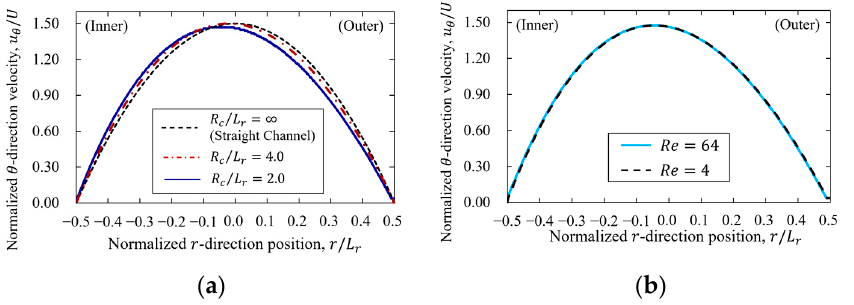
Figure 3. Velocity profiles of curvilinear channel with l = 200 cells. ( a ) Difference in velocity profiles between curvilinear channel and straight channel with Re = 32. ( b ) Reynolds number Re dependence using R c / L r = 2.0. Table 1. Shear rate at each radial length of curvature and location where γ = 0. Radial Length of Curvature R c / L r Normalized r -Direction Position for γ =0 4.0